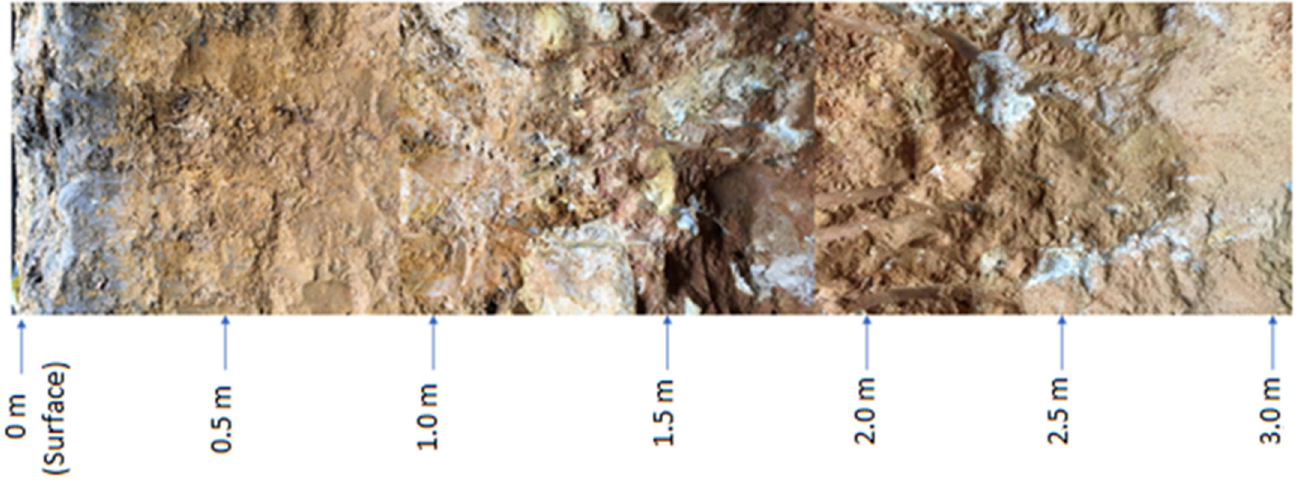
Figure 3. Samples taken for a laboratory texture test.